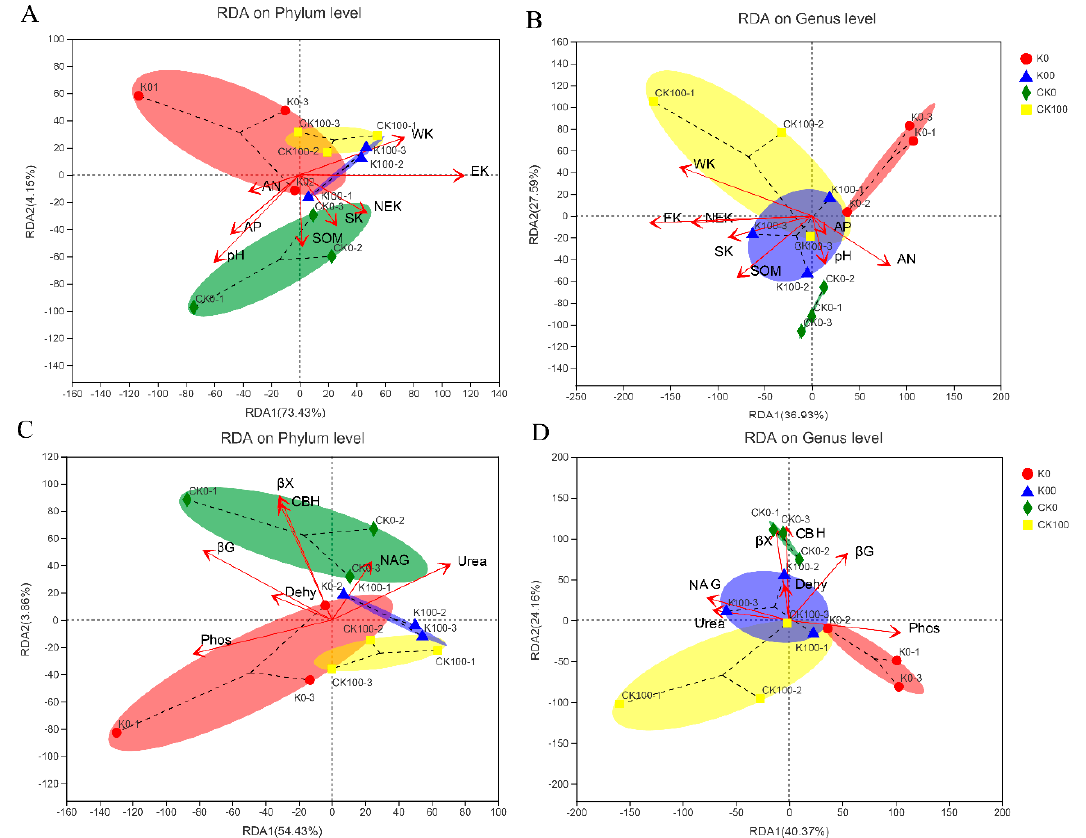
Figure 5. Results of redundancy analysis of acidic soils. ( A , B ) represent soil chemical properties on phylum and genus levels. ( C , D ) represent soil enzyme activity on phylum and genus levels.